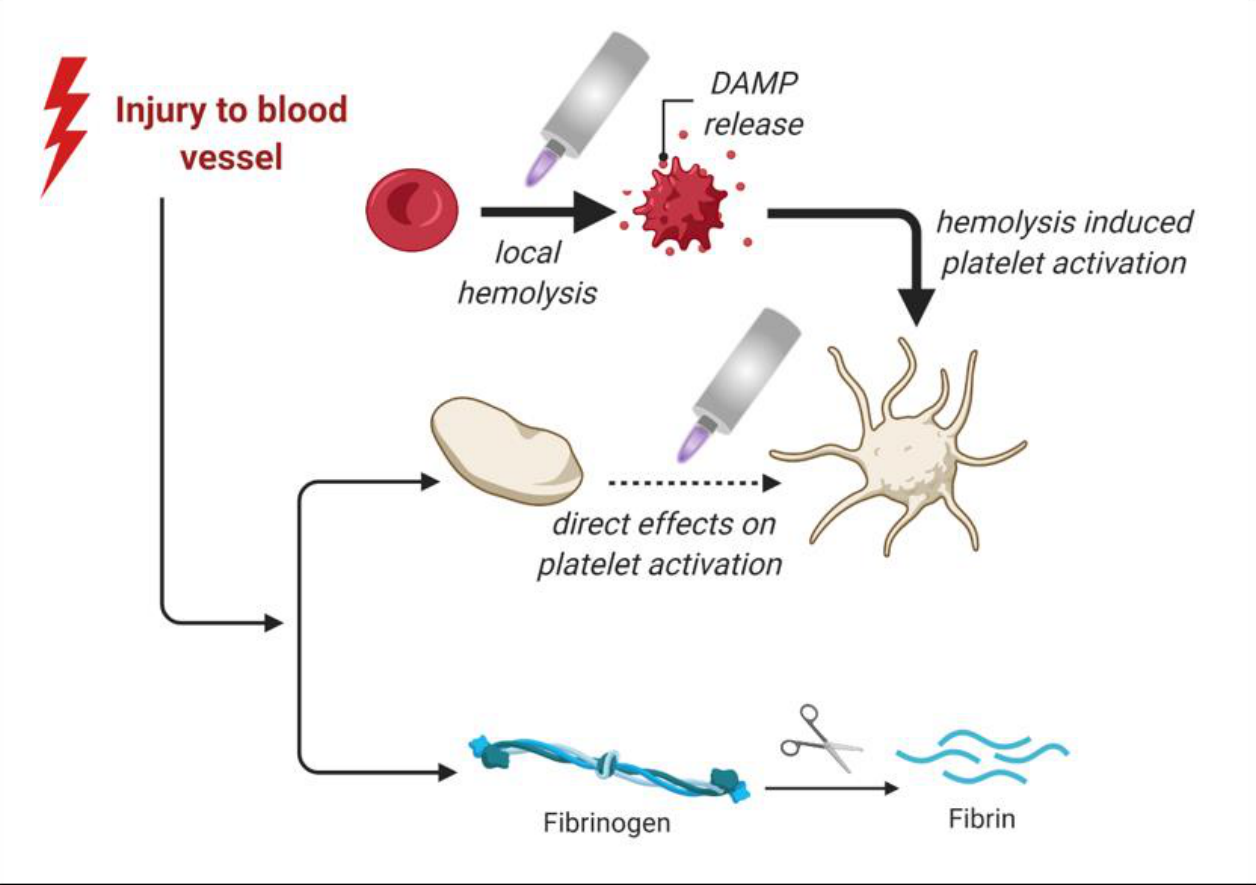
Figure 4. Putative modes of action of gas plasma during hemostasis. Created with biorender.com (accessed on 1 February 2022).